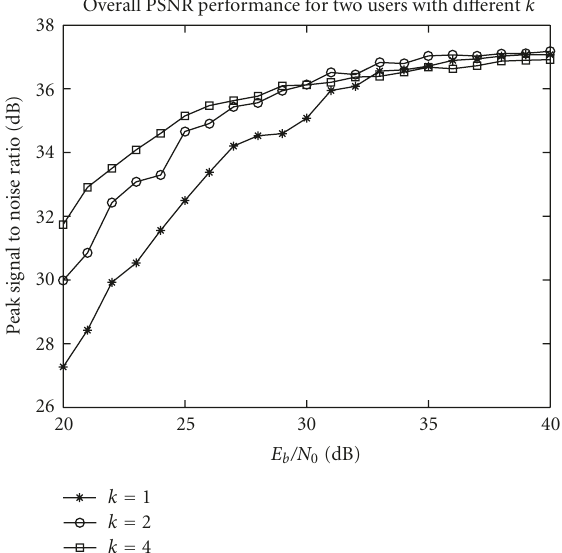
Figure 17: The PSNR performance for QVGA resolution with di ff erent space ratio k . The priority of each data packet is labeled and aware of by the MAC layer.